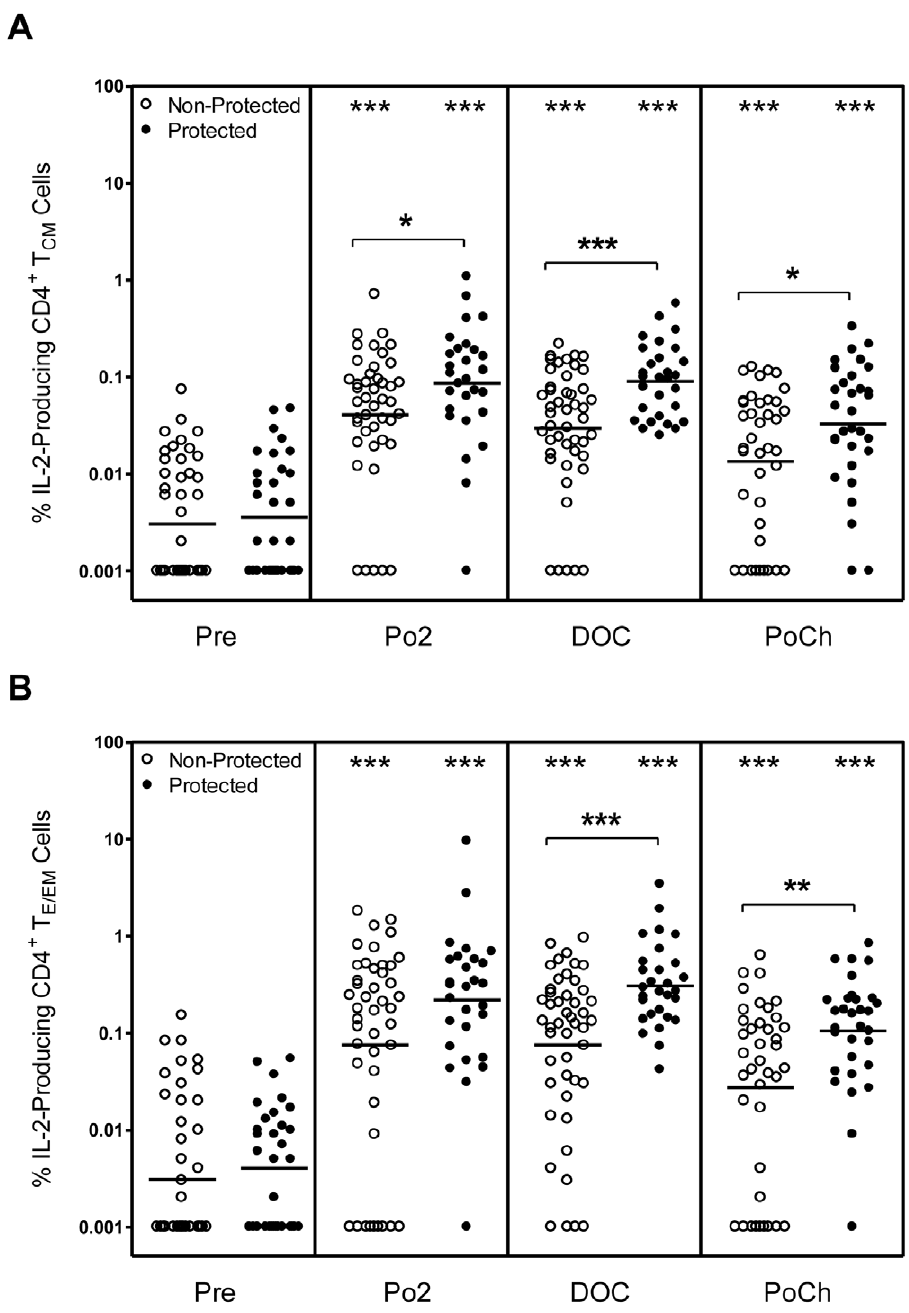
Figure 2. Frequency of CD4 + T CM and CD4 + T E/EM cells producing IL-2 upon recall with CSP peptides. PBMC were obtained at the Pre, Po2, DOC and PoCh timepoints from RTS,S-immunized subjects and were incubated for 18 h with co-stimulants (medium control) or co-stimulants plus a pool of 2 long contiguous CSP peptides as described in Methods. Cultures also contained PE-conjugated-CCR7-specific Ab to detect CCR7 + cells. Cells were harvested and surface-labeled for CD3, CD4, CD8 and CD45RO and then stained for intracellular detection of IL-2, TNF- a and IFN- c (see Methods and Fig. 1). Cells were analyzed on an LSR-II flow cytometer to identify IL-2-producing CCR7 + CD45RO + CD4 + T CM cells and CCR7 2 CD45RO + CD4 + T E/EM cells. The frequency of IL-2-producing CD4 + T cell subsets in the medium control cultures were subtracted from the corresponding values for the CD4 + T cell subsets in the cultures containing Ag. The resulting adjusted values are plotted as [A] the % IL-2 producing CD4 + T CM cells and [B] the % IL-2 producing CD4 + T E/EM cells for protected (closed symbol) and non-protected (open symbol) subjects. Statistically significant differences between pre-immune and post-vaccination time points are indicated at the top of the graph. Statistically significant differences between values for protected and non-protected subjects are as indicated within the body of the graph. *p , 0.05; **p , 0.01; ***p , 0.001.